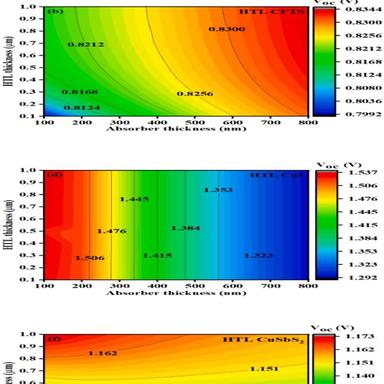
Contour mapping of Voc for FASnI3 absorber and HTLs thickness (a) CBTS (b) CFTS (c) Cu2O (d) CuI (e) CuO (f) CuSbS2 (g) CuSCN.